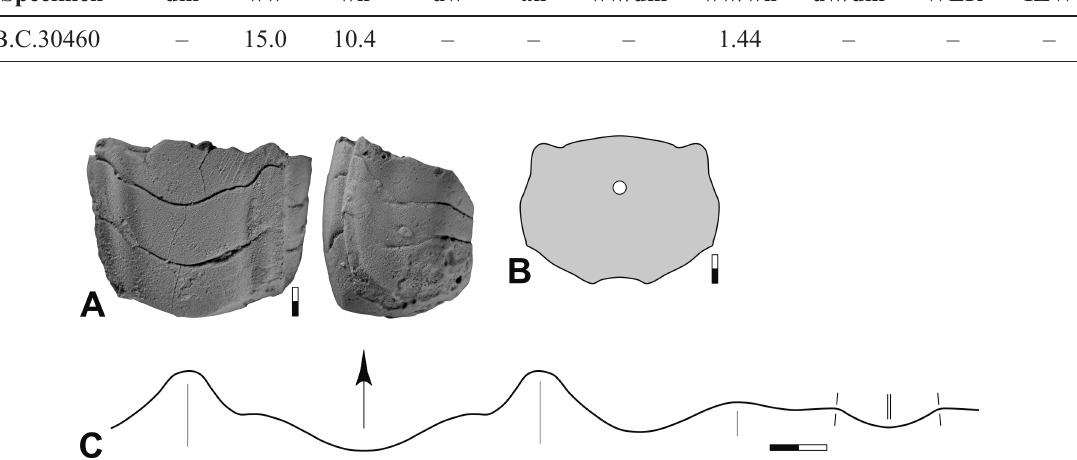
Fig. 13. Stroboceras sp. from Timimoun, specimen MB.C.30460 (Korn et al . 2002 Coll.). A . Ventral and lateral views. B . Whorl profile. C . Suture line, at ww = 14.3 mm, wh = 10.3 mm. Scale bar units = 1 mm.